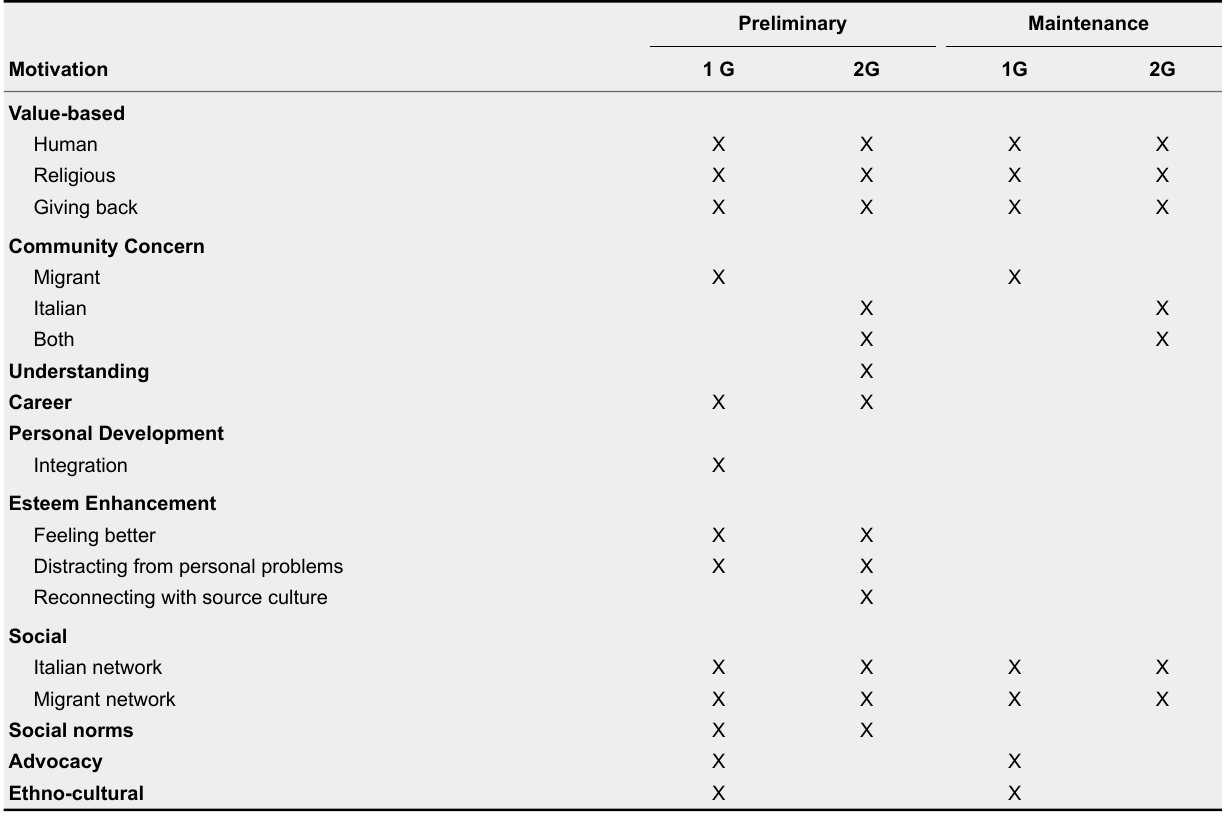
Type of Motivations to Volunteer Divided by Stage and